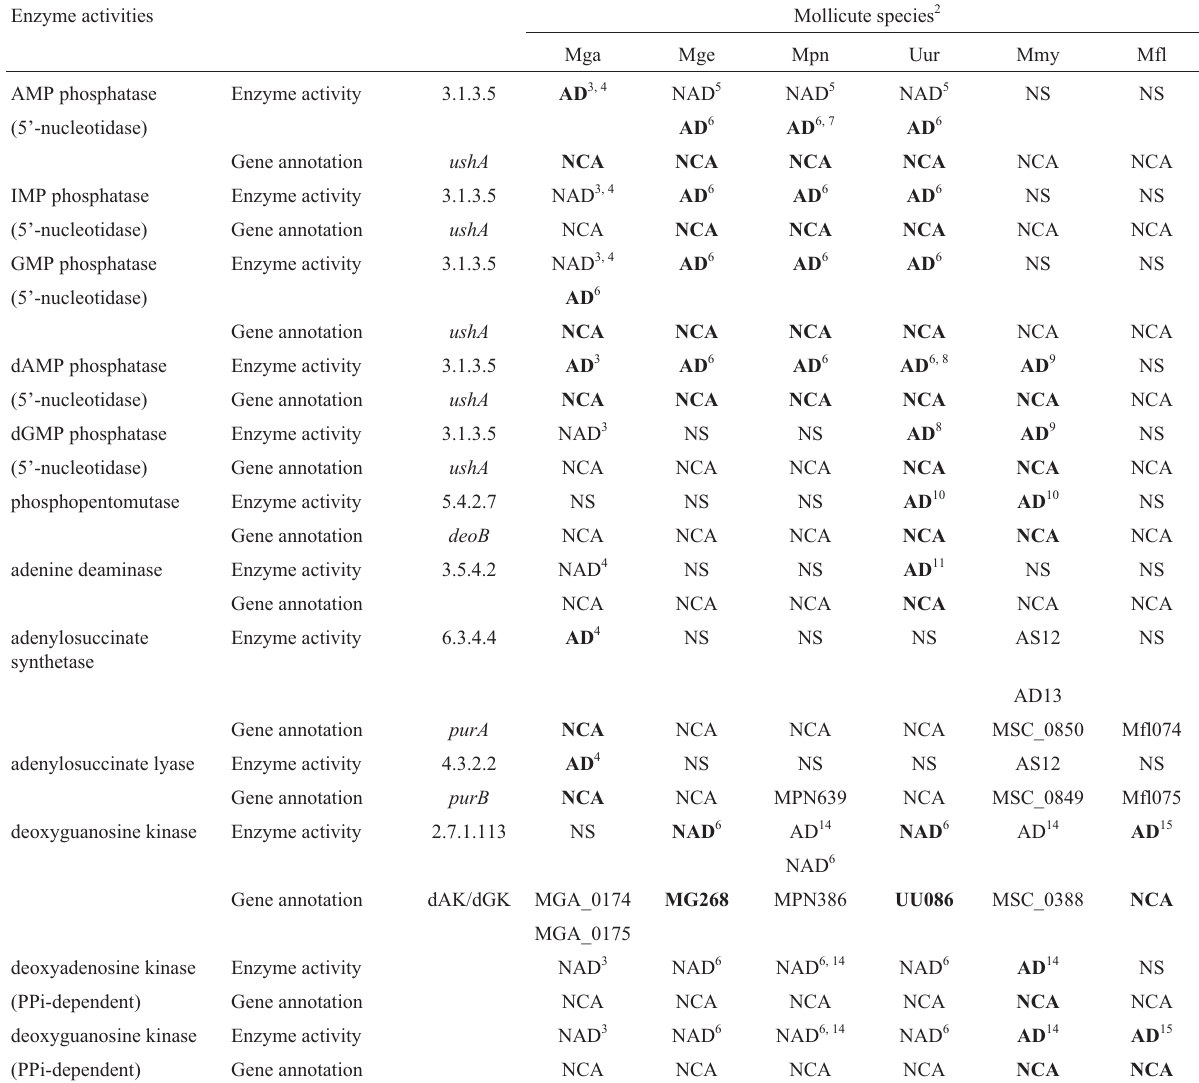
Table 1 - Differences between enzyme activity assays and gene annotation in purine nucleotide metabolism 1 . Enzyme